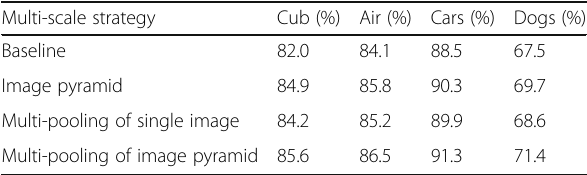
Table 2 Evaluation of multi-pooling Multi-scale strategy